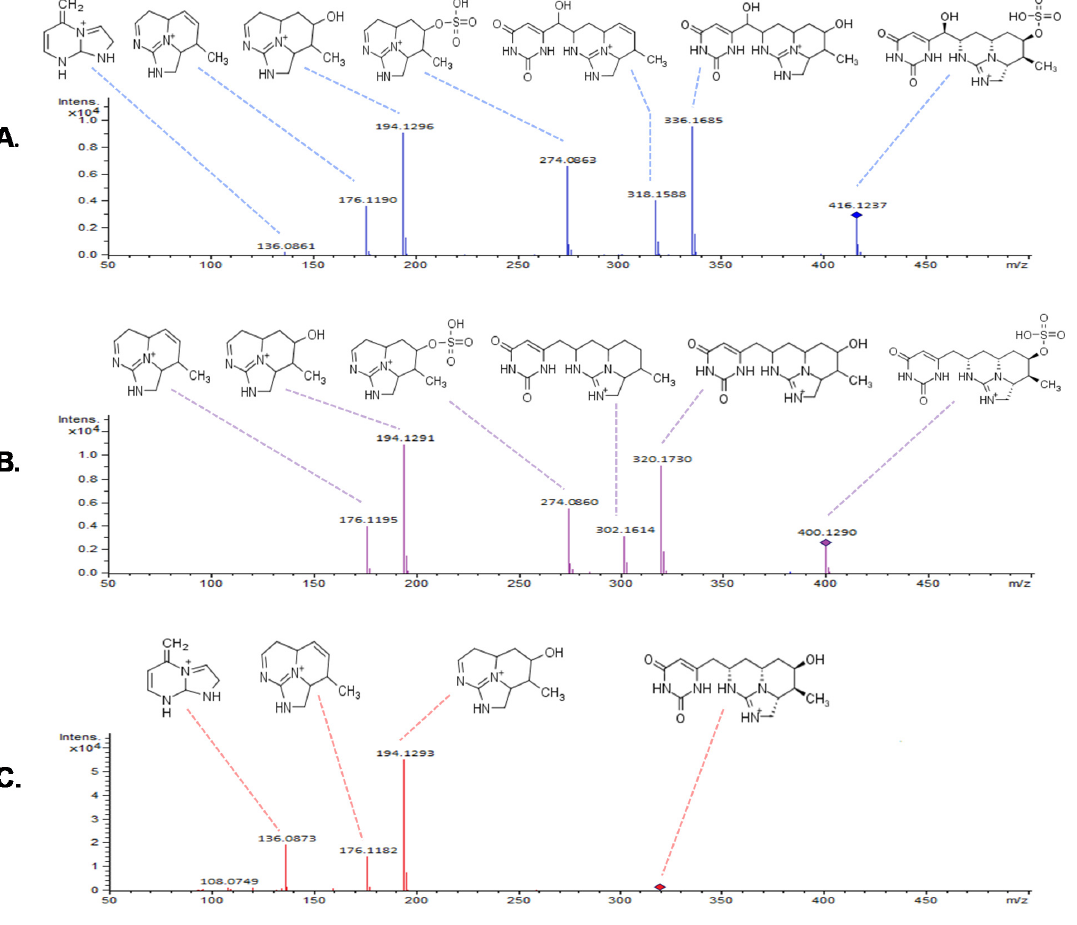
Figure 4. Proposed structure assignment of CYNs fragmentation patterns on a QTOF mass analyzer: ( A ) CYN at 20 eV, ( B ) 7D-CYN at 20 eV and ( C ) 7D-desulfo-CYN at 35 eV. Structure assignment was based on previous calculations by Dörr et al. (2010) [26].